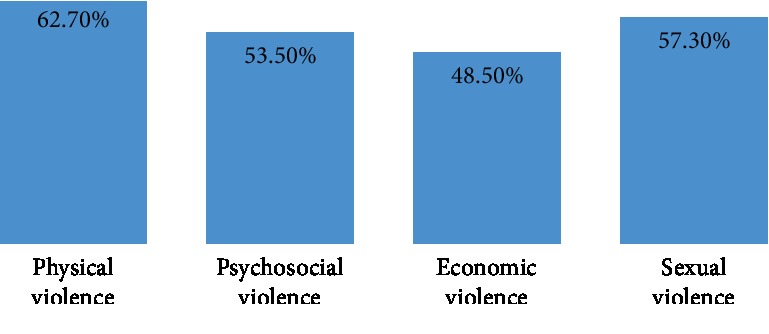
Forms of IPV in pregnancy experienced by respondents (multiple responses considered).